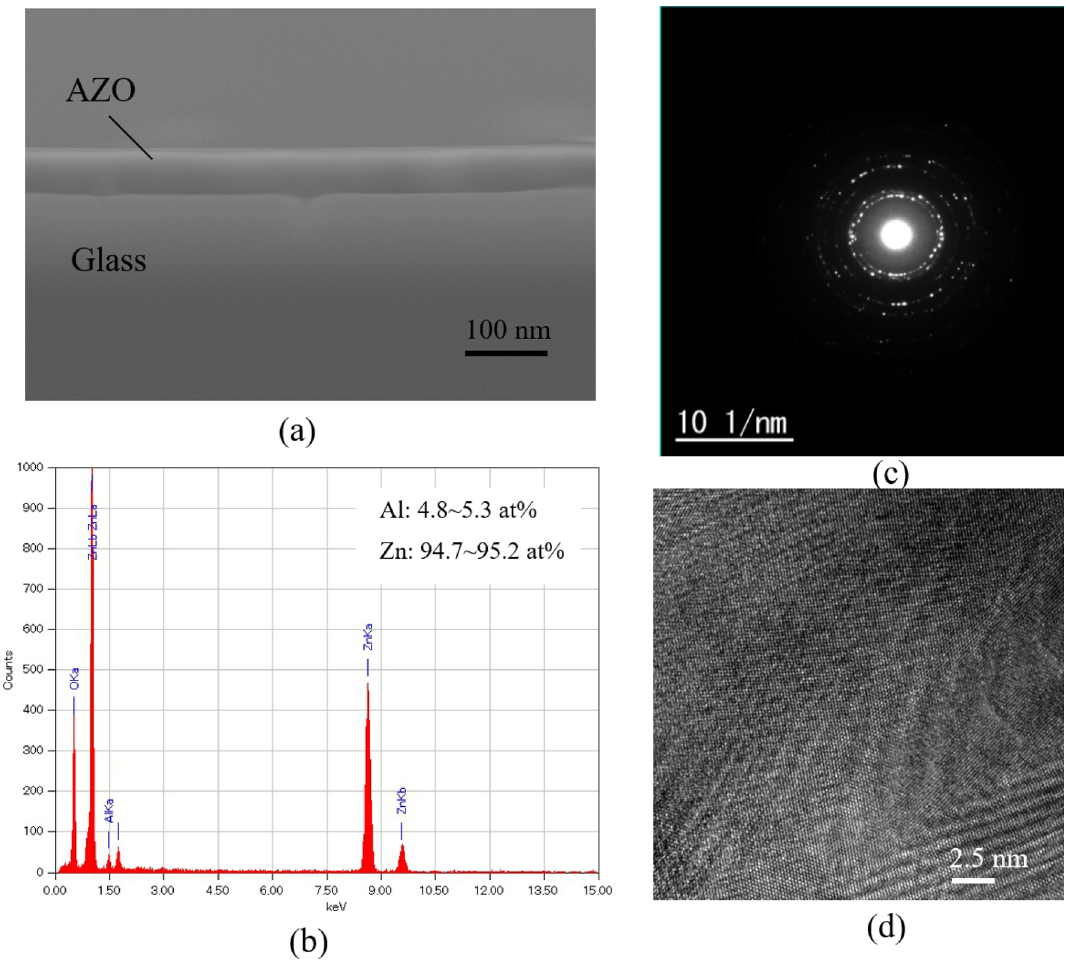
Figure 1. Morphology analysis. ( a ) Cross-sectional SEM image of the deposited film. ( b ) Element composition of the deposited film was analyzed by EDX. ( c ) Selected area electron diffraction of the film. ( d ) Transmission electron microscopy image of the film.